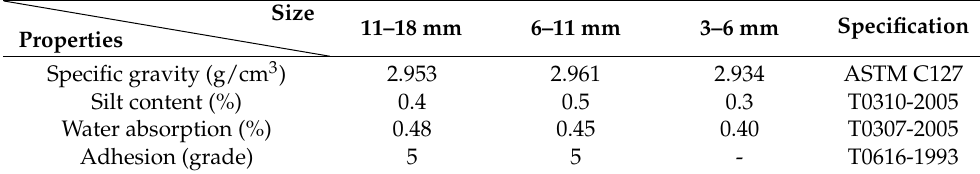
Table 2. Basic performance indicators of coarse basalt aggregate.